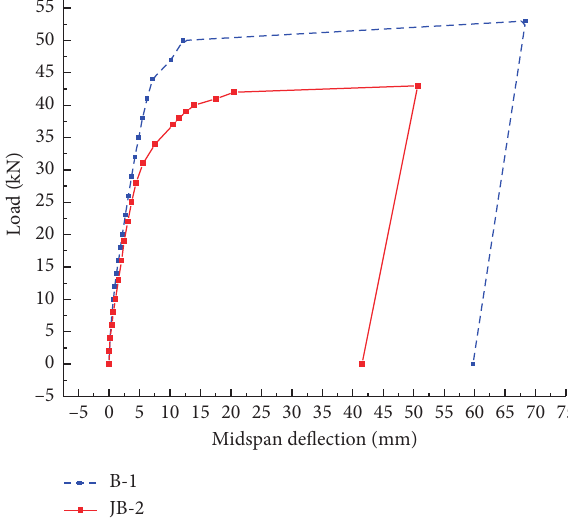
Figure 4: Load versus midspan deflection curves under monotonic loads.